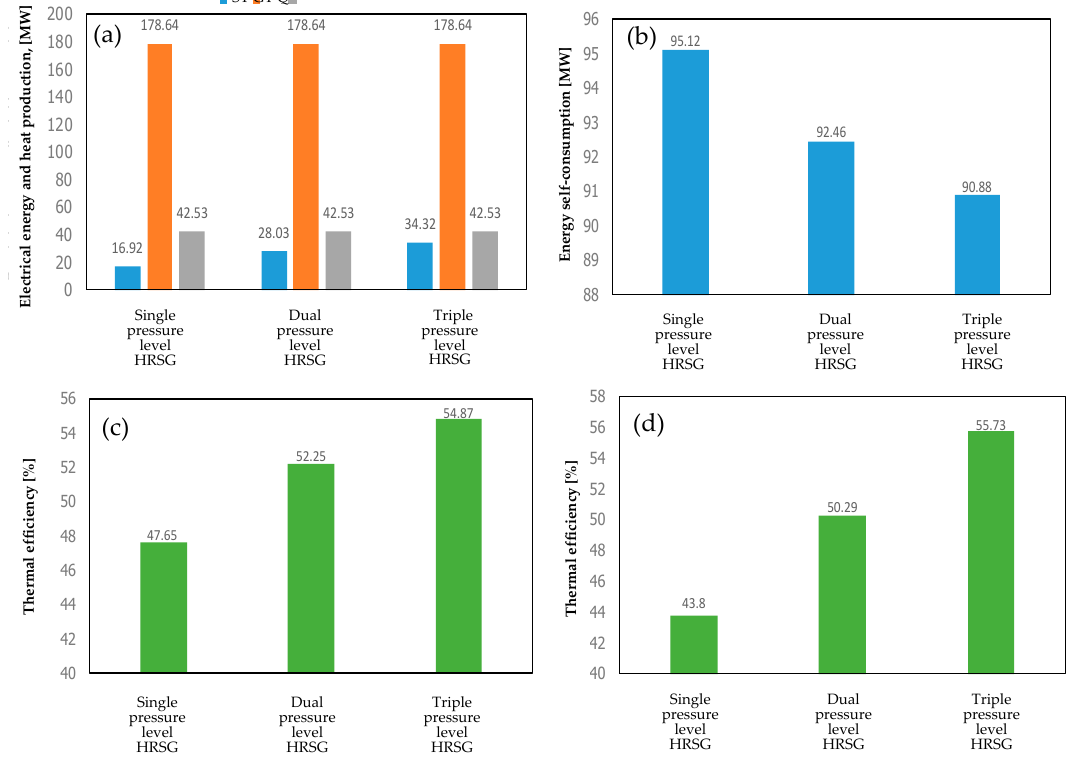
Figure 3. Electrical energy from GT, ST and heat production Q ( a ), energy self-consumption ( b ) and overall system thermal e ffi ciency for the system with 1P, 2P, and 3P HRSG without ( c ) and with ( d ) inter-stage steam overheating.